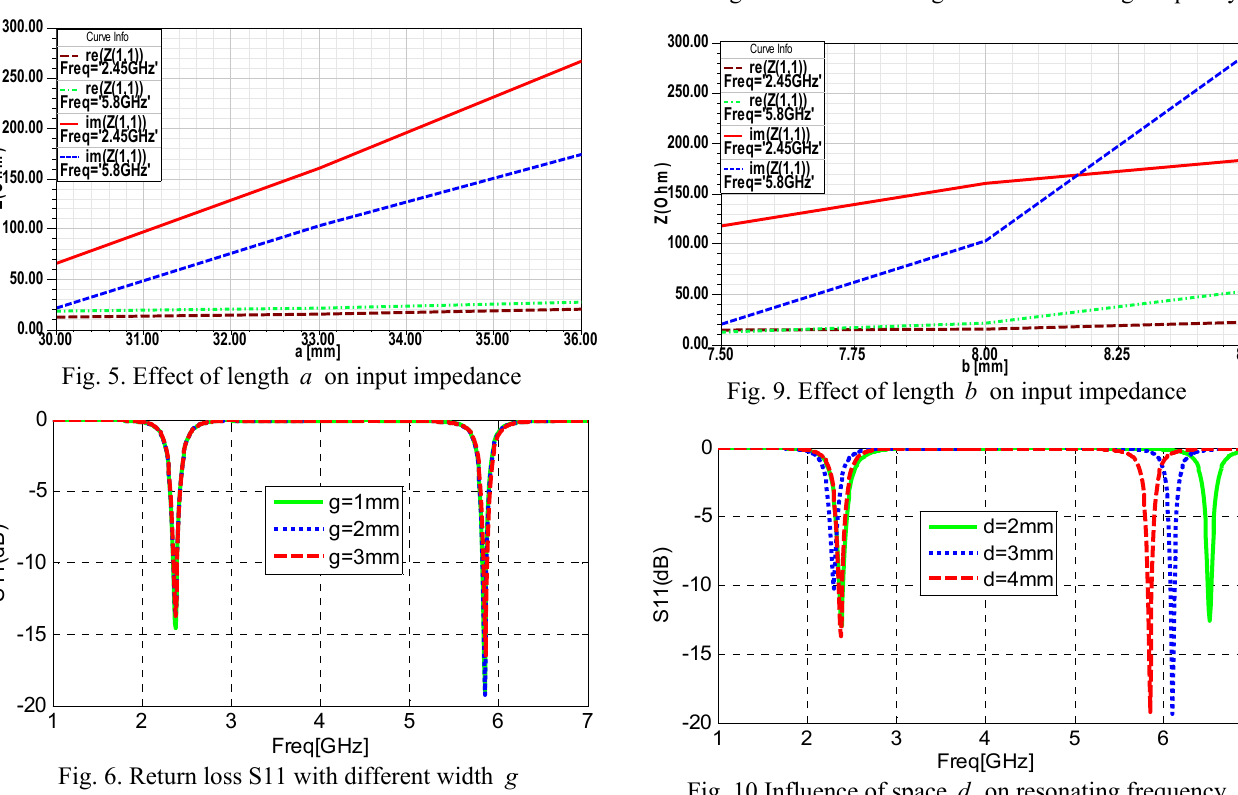
Fig. 8 Influence of length b on resonating frequency